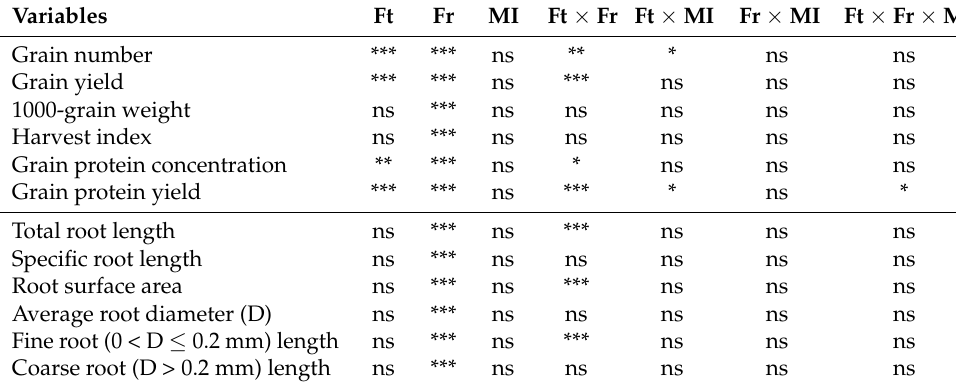
Table 3. Analysis of variance (ANOVA) summary assessing the effects of fertiliser type (Ft), fertiliser rate (Fr), microbial inoculant (MI) and their interactions on yield components, protein concentration and yield, and root morphology of wheat. *, ** and *** denote significance at p ≤ 0.05, 0.01 and 0.001, respectively; ns, non-significant at p > 0.05.